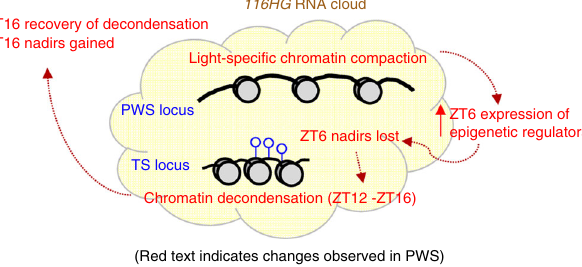
Fig. 8 Model of dysregulated epigenetic events throughout the diurnal cycle in PWS. The PWS locus becomes condensed during light hours (ZT0 – ZT12). Epigenetic regulators are expressed at aberrantly high levels at ZT6 and DNA methylation nadirs are lost at ZT6 (including at the TS locus). The TS locus undergoes delayed decondensation (ZT12 – ZT16), potentially to compensate for PWS locus compaction. By ZT16, PWS decondensation is restored and DNA methylation nadirs are gained, representing a diurnal shift in rhythmic methylation and a light-speci fi c dysregulation of chromatin decondensation. Red text indicates changes observed in Snord116 + / − . Open circles indicate drugs in the United States target diurnally oscillating genes (56 of the top 100) 7 . The short half-life of many of these drugs and the rhythmic expression of their targets suggests that the time of administration plays a potentially important role in the ef fi cacy of treatment. By characterizing the epigenetic mechanisms of PWS with respect to the diurnal cycle, this study demonstrates the potential application of chronotherapy for the treatment of PWS as well as other epigenetically regulated neurodevelopmental, metabolic, and sleep disorders.